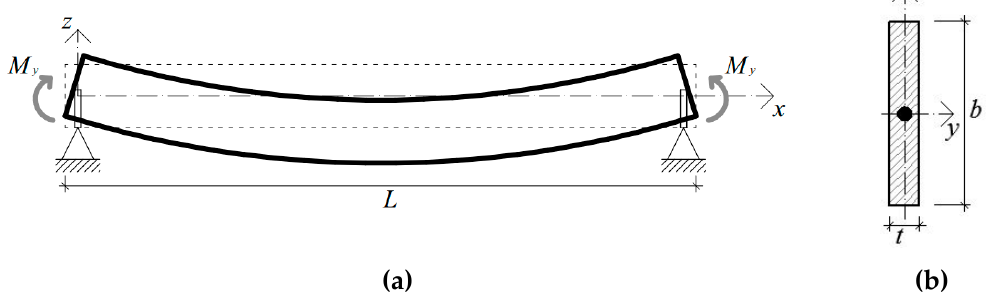
Figure 3. Lateral–torsional buckling (LTB) reference system for a laterally unrestrained (LU) monolithic beam under constant bending moment M y : ( a ) front view and ( b ) nominal cross-section.